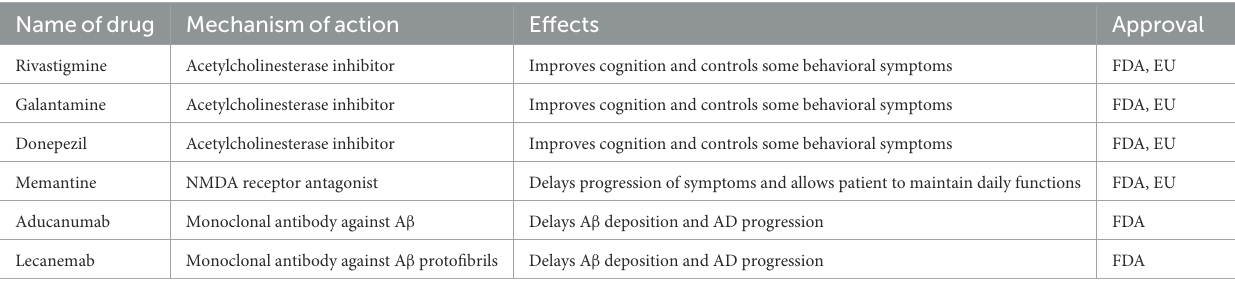
TABLE 2 List of drugs approved for treatment of